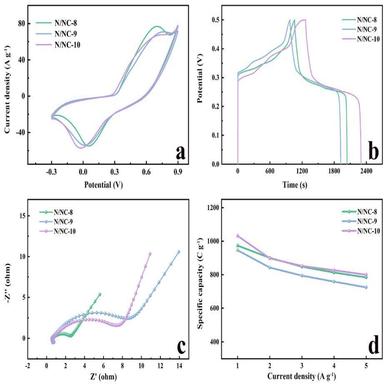
The electrochemical properties of N/NC-8, N/NC-9 and N/NC-10. CV curves at 30 mV s − 1 (a), GCD curves at 1 A g− 1 (b), the Nyquist plots of impedance data (c) and specific capacity at various current densities from 1 A g− 1 to 5 A g− 1 (d).